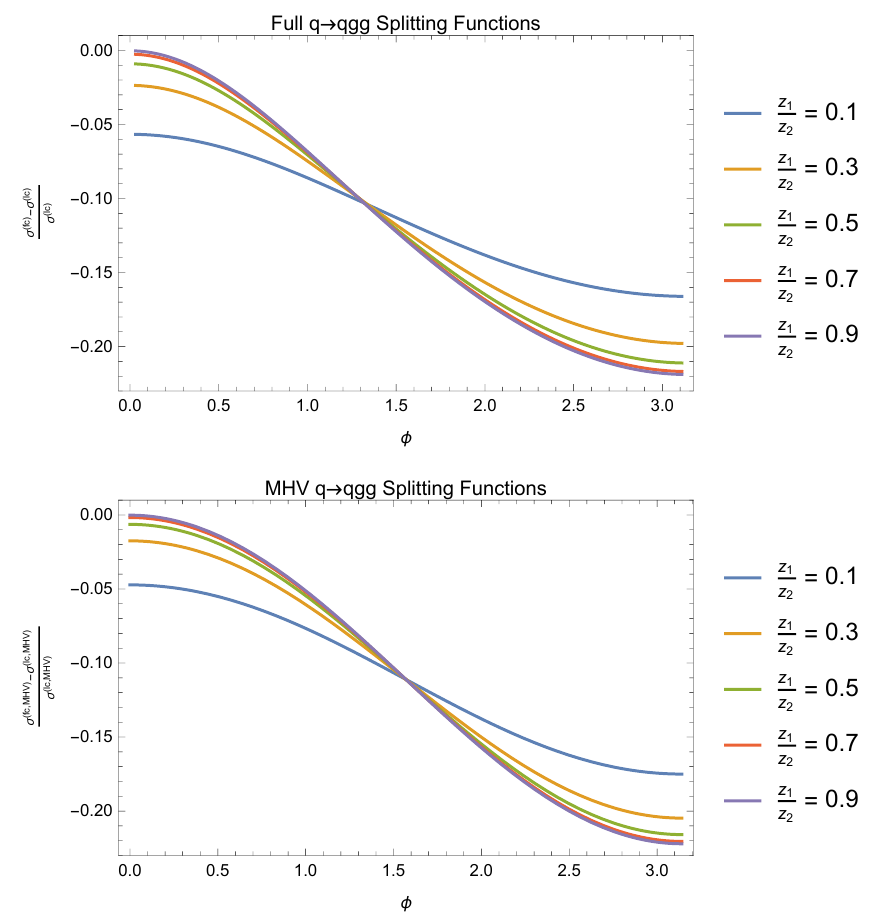
Figure 4: Plot of the relative sinusoidal color interference between the full- and leading-color contributions to the complete q → qg g collinear splitting functions (top) and the MHV collinear splitting function result of Eq. 42 (bottom). The colors correspond to different ratios of the distances of the two gluons to the